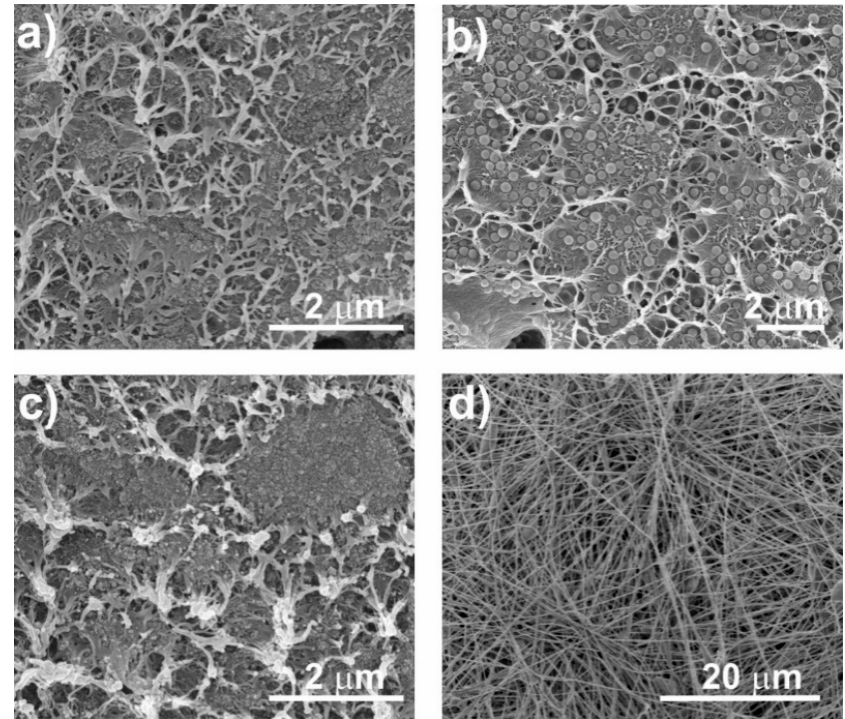
Figure 3. Cross section SEM micrographs of SiNPs/PVDF nanocomposite samples with nanoparticles of different diameters and different processing conditions: ( a ) F90-17NP, ( b ) F90-300NP, ( c ) F210-17NP, ( d ) R-17P.